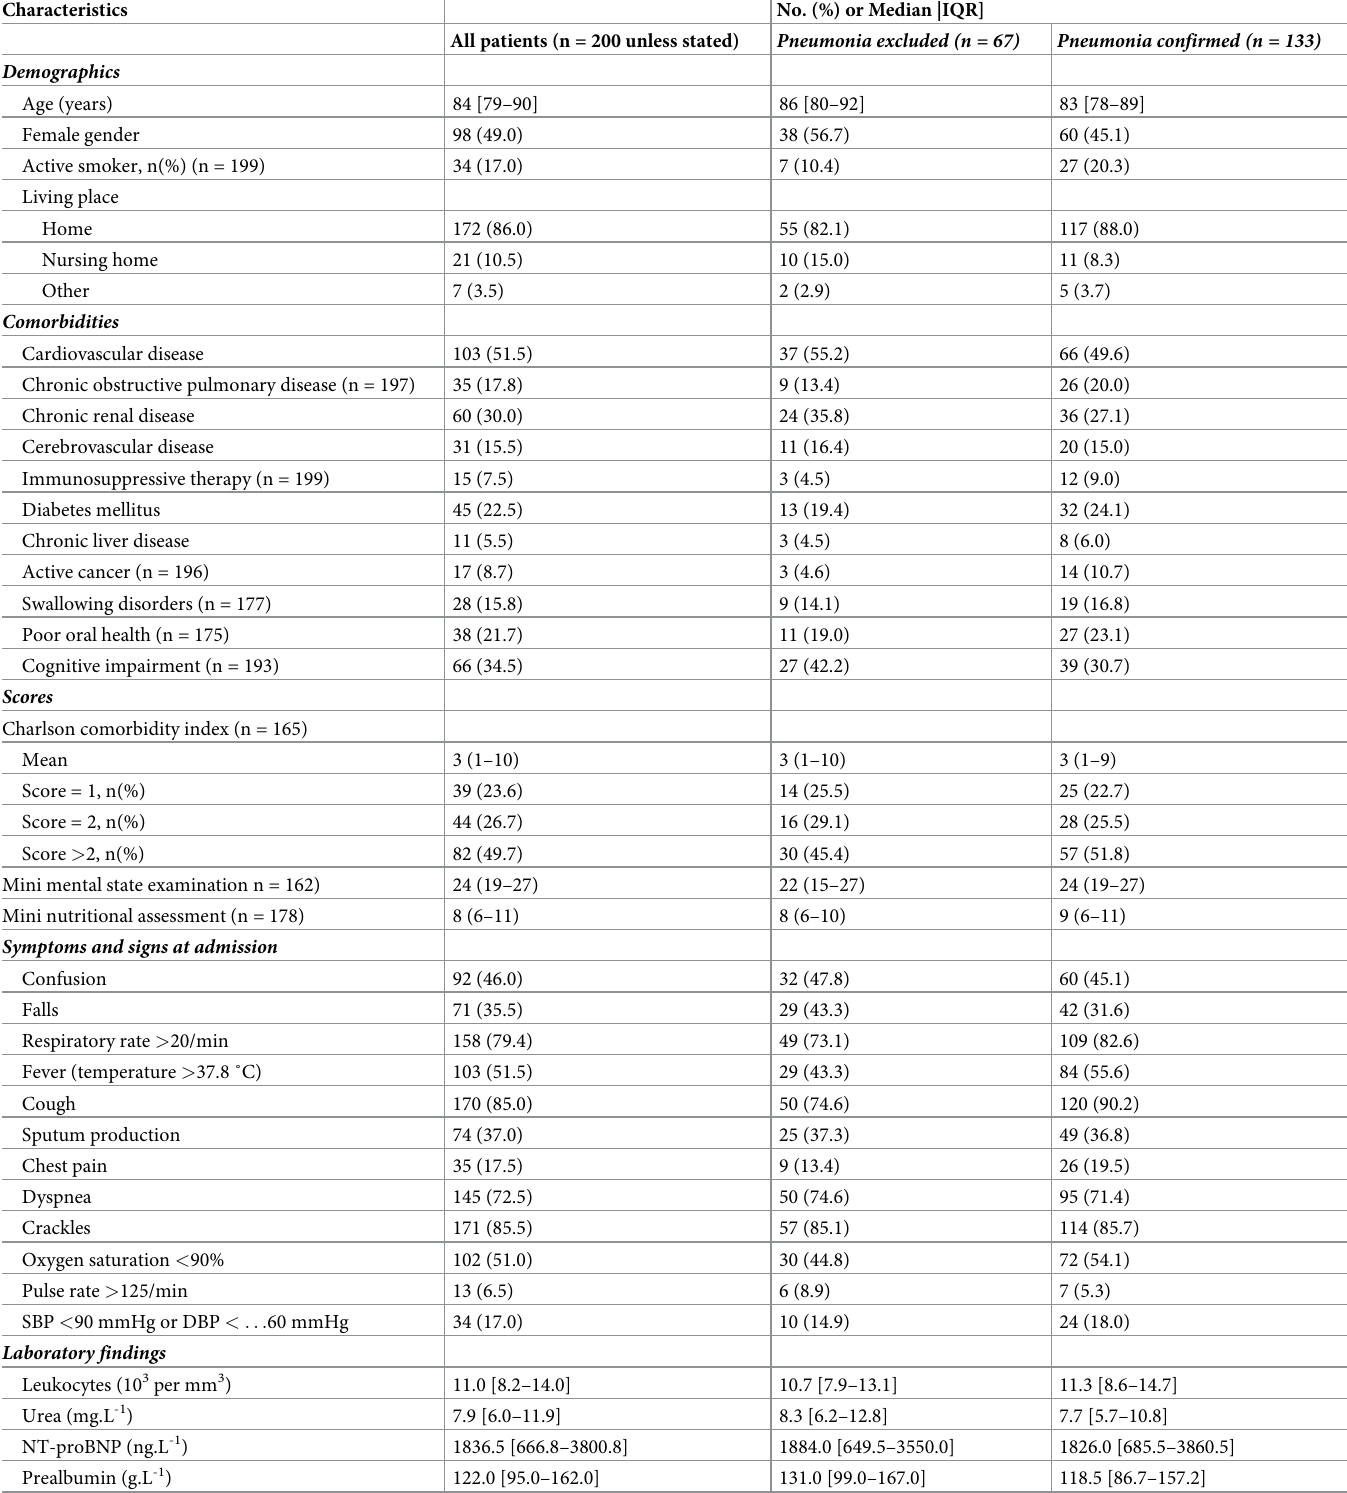
Table 1. Baseline characteristics of the 200 patients included.